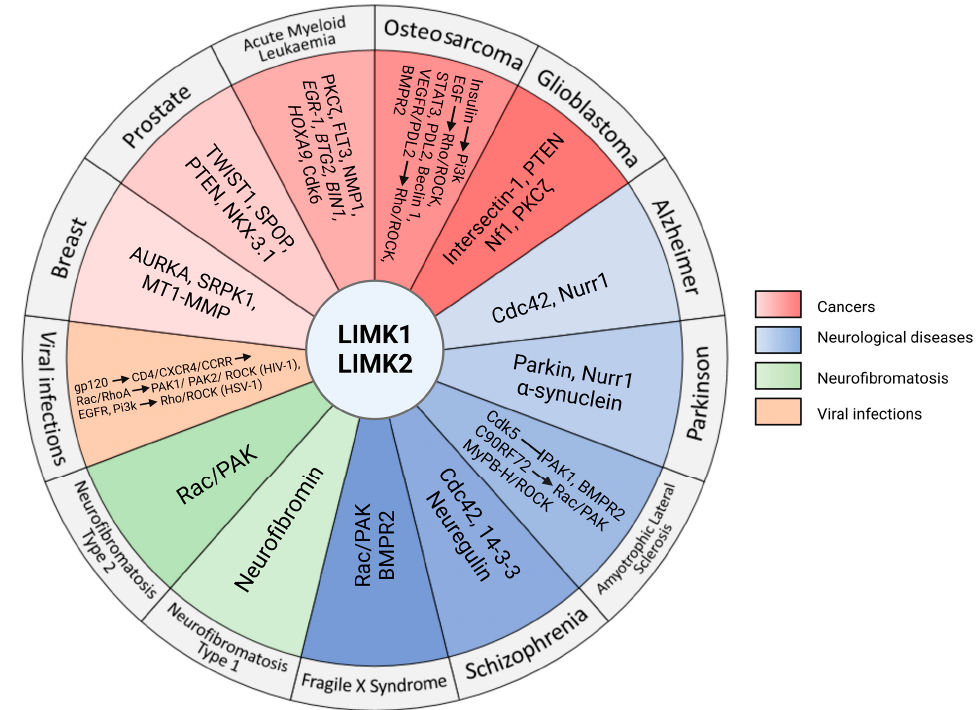
Figure 10. Involvement of LIM kinases in different pathologies. LIMK partners and LIMK mis-regulated signalling pathways implicated into these pathologies are also highlighted.